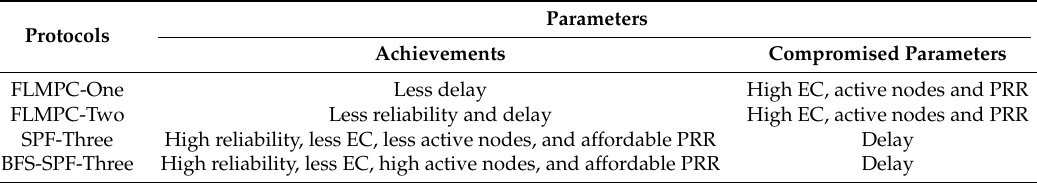
Table 10. Performance Trade-offs between Existing and Proposed